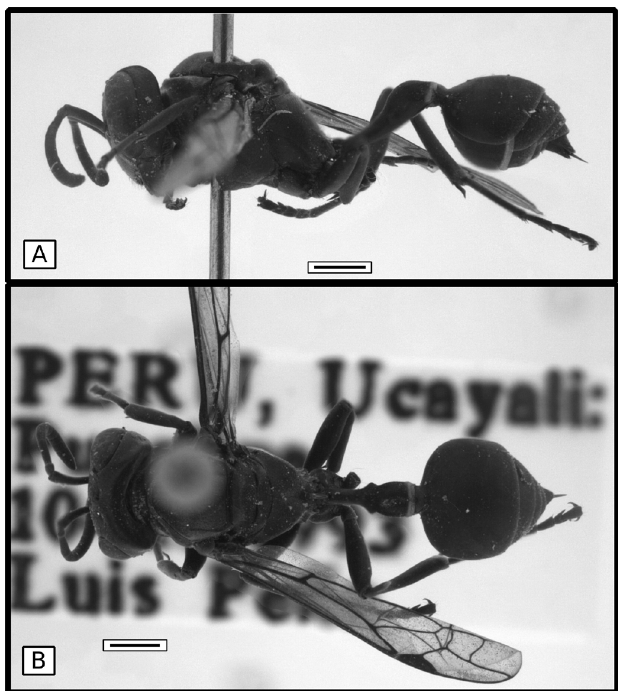
Fig 2 . Metapolybia fraudator from Peru, Ucayalli: A= lateral view; B= dorsal view. Escale bar = 1.0